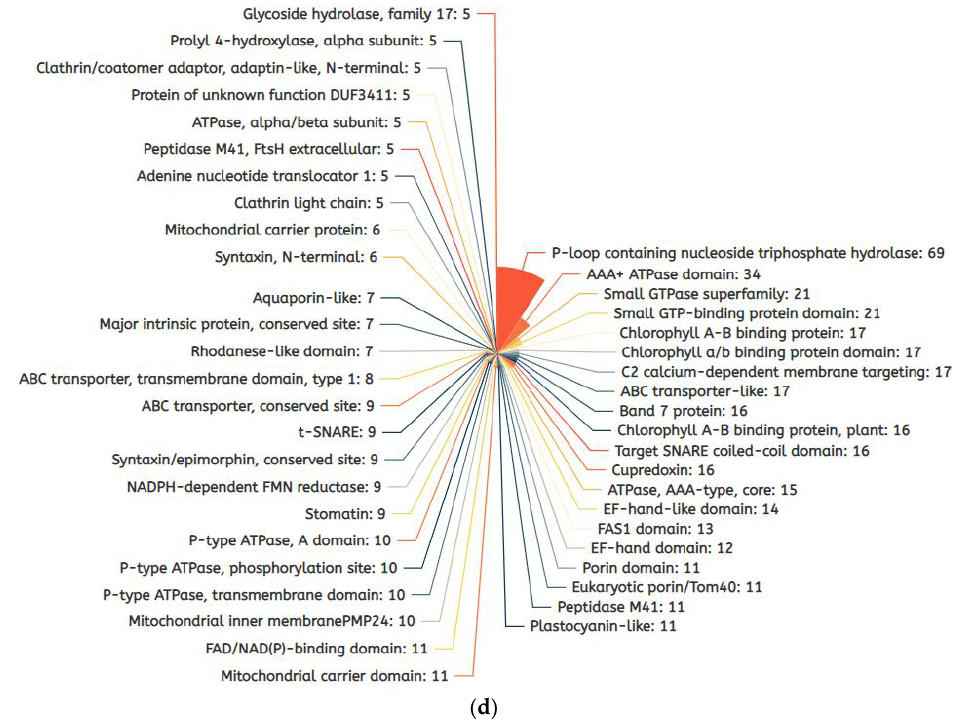
Figure 4. Overview of identified transmembrane domain-containing proteins from both leaf and root tissues in various categories based on their molecular functions, cellular components and types of proteins. ( a ) Venn diagram showing the numbers of commonly shared, leaf-specific and root- specific membrane proteins. ( b ) Distributions of membrane proteins according to molecular functions. ( c ) Distributions of the membrane proteins in various cellular components. ( d ) Classification of the membrane proteins based on their transmembrane domains.